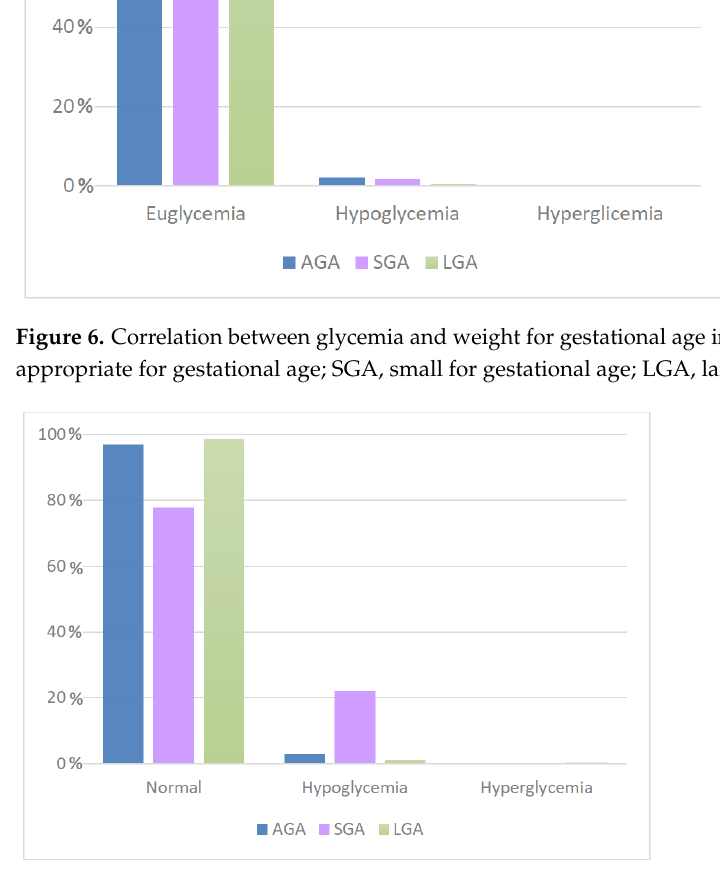
Figure 7. Correlation between glycaemia and weight for gestational age in continuous feeding. AGA, appropriate for gestational age; SGA, small for gestational age; LGA, large for gestational age. Table 6. Association between weight for GAs and blood glucose alterations in patient in continuous feeding. p -value = 0.001. AGA, appropriate for gestational age; SGA, small for gestational age; LGA, large for gestational